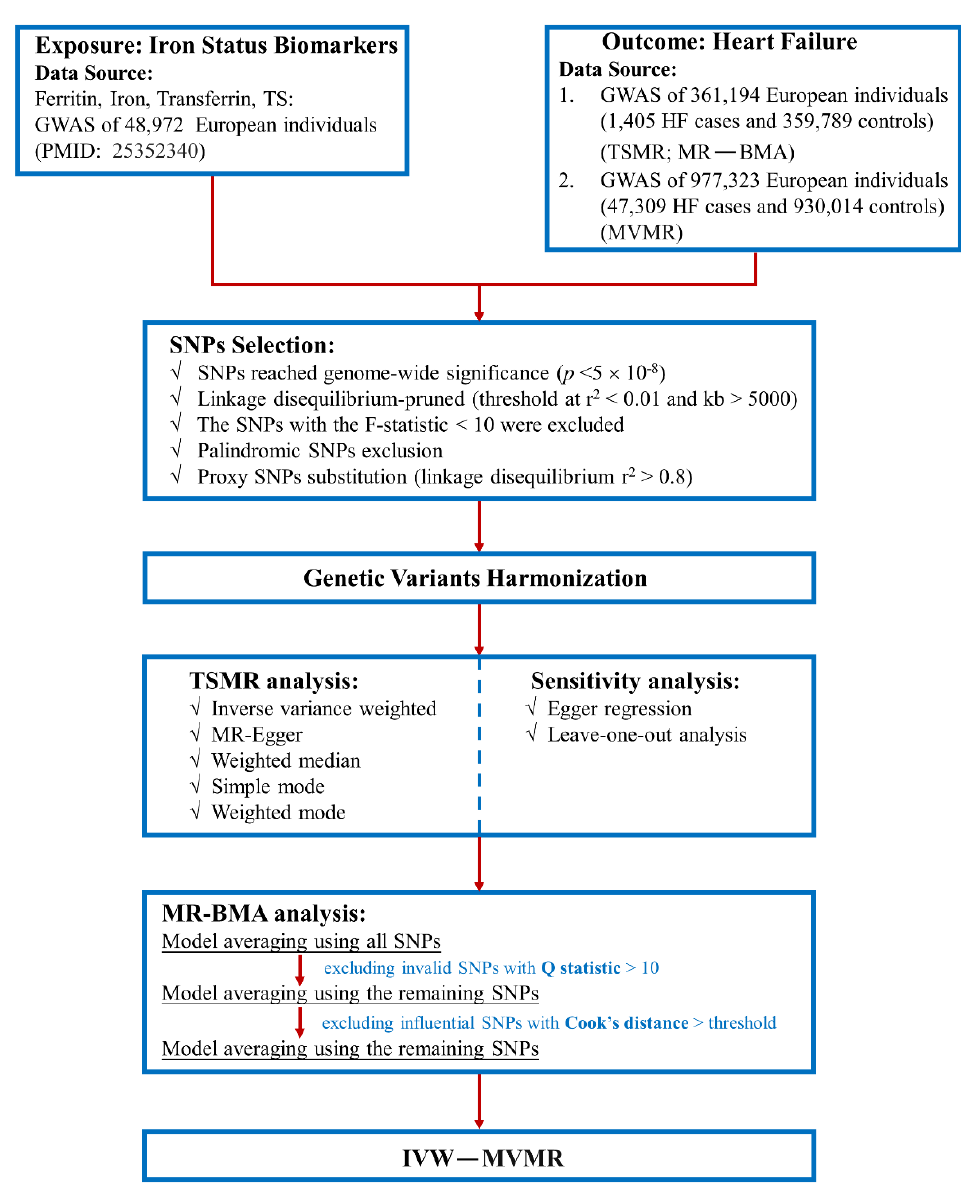
Figure 2. Flowsheet of Mendelian randomisation in this study. TS—transferrin saturation; BMA—Bayesian model averaging.